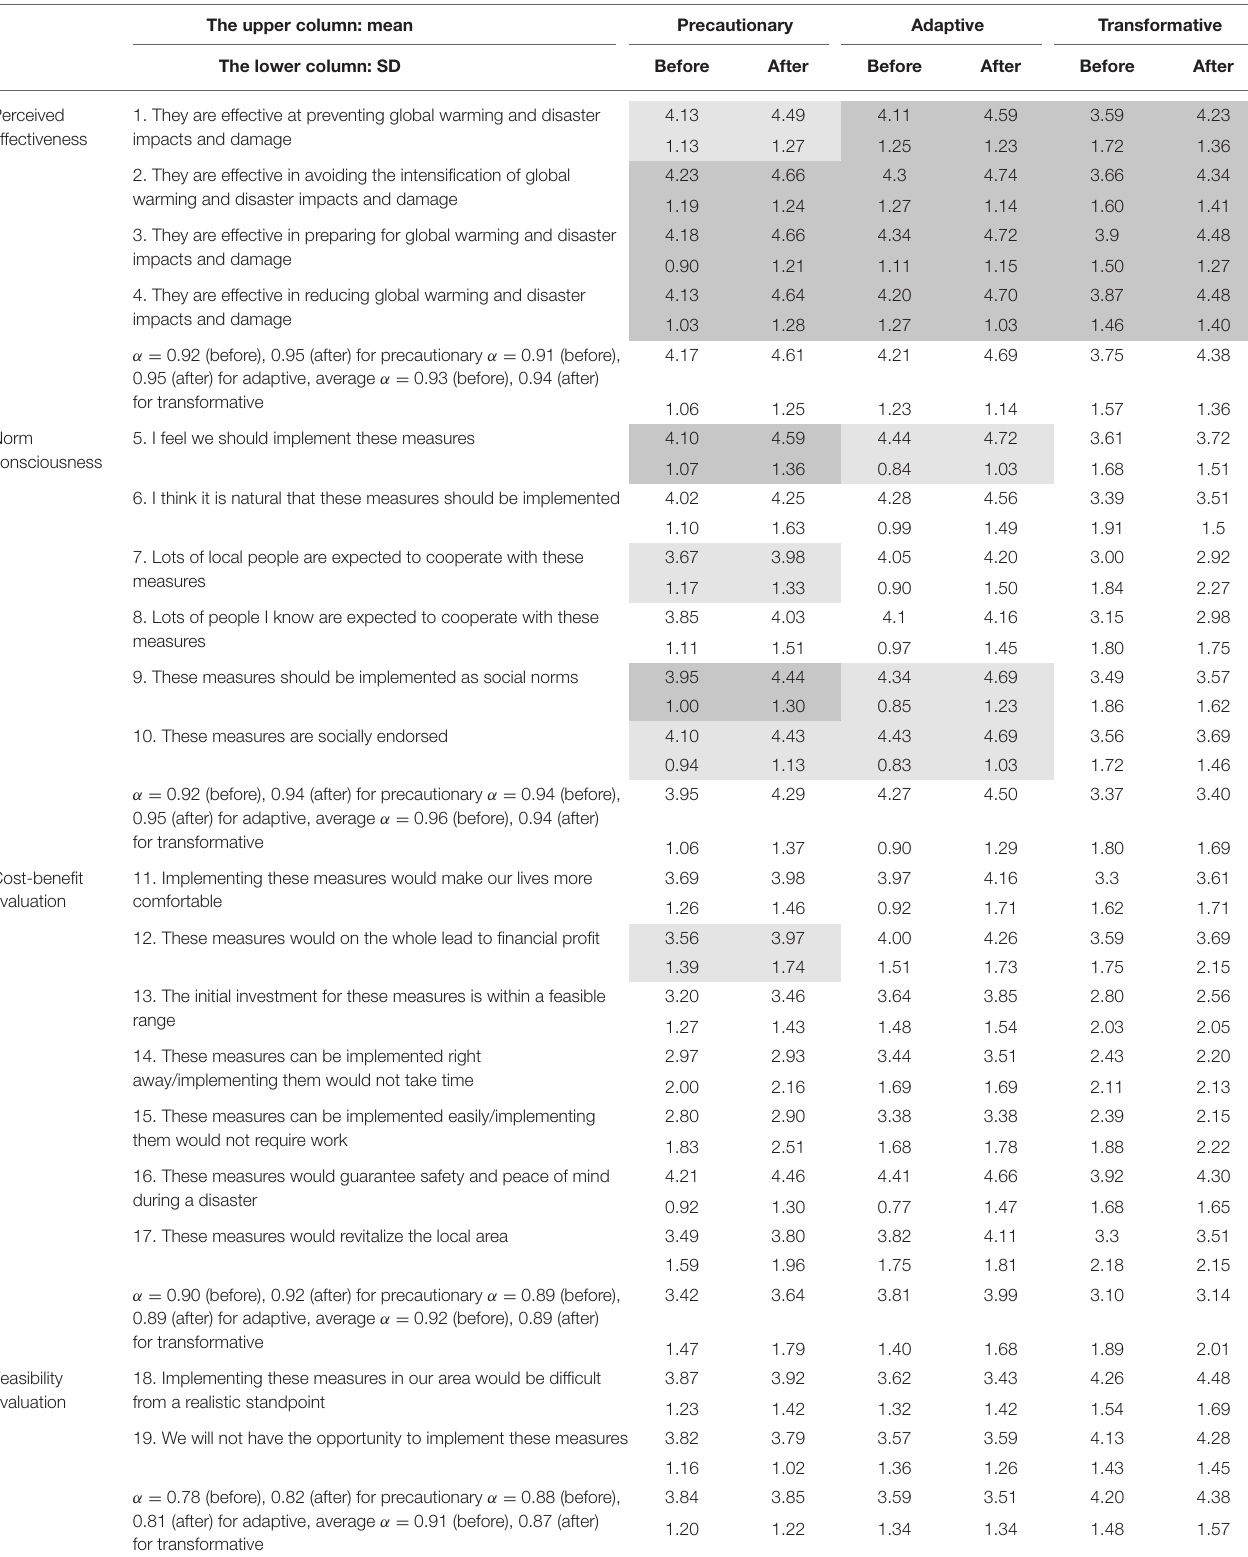
Dark shaded = 1% significance; light shaded = 5%